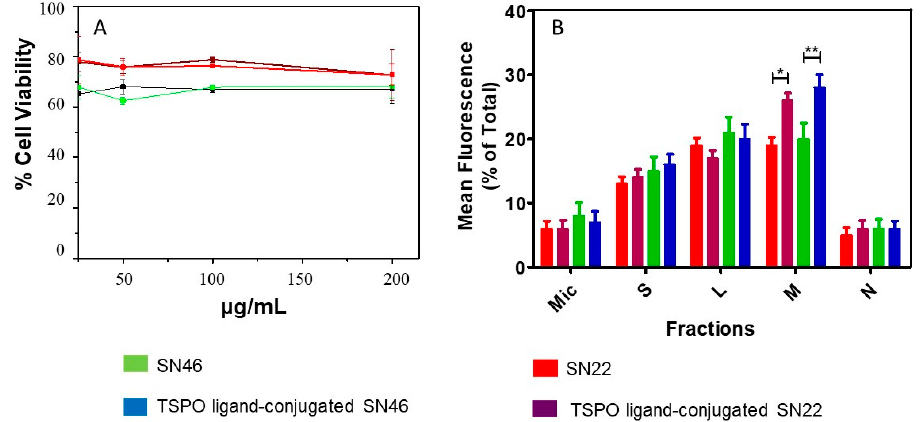
Figure 5. Cell viability profiles of U87MG cells incubated with amino functionalized SN22 and SN46 samples before ( A , red line and green line, respectively) and after ( A , wine line and blue line, respectively) their conjugation with TSPO ligand, for 24 h. Each point represents a mean value of three independent experiments. Subcellular fractionation of U87MG cells after incubation with amino functionalized SN22 and SN46 NPs ( B , red and green bars) and TSPO ligand bioconjugates ( B , vine and blue bars). Key: microsomal (Mic), soluble (S), lysosomal (L), mitochondrial (M) and nuclear (N) fractions. Statistical values p < 0.05 (*) and p < 0.01 (**) estimated by two-way ANOVA and Bonferroni post hoc test. Data represents mean ± SD, n = 3.